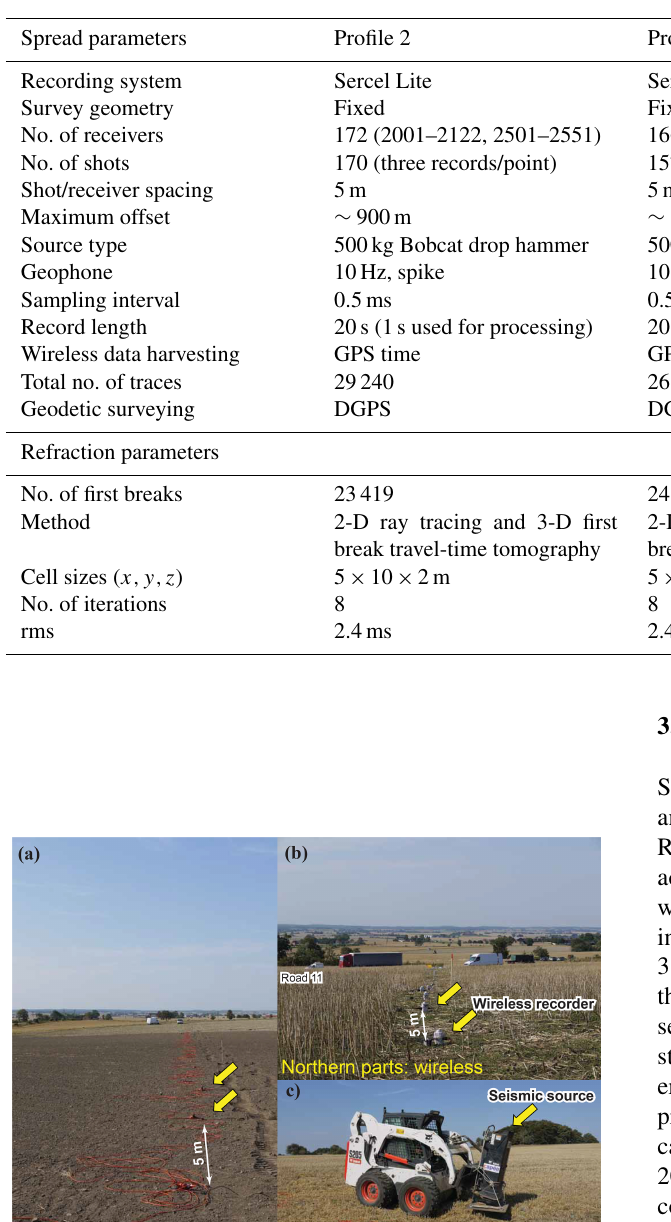
Table 1. Main seismic acquisition and refraction parameters of the Dalby data (August 2015). DGPS indicates differential GPS. Root mean square is indicated by rms.